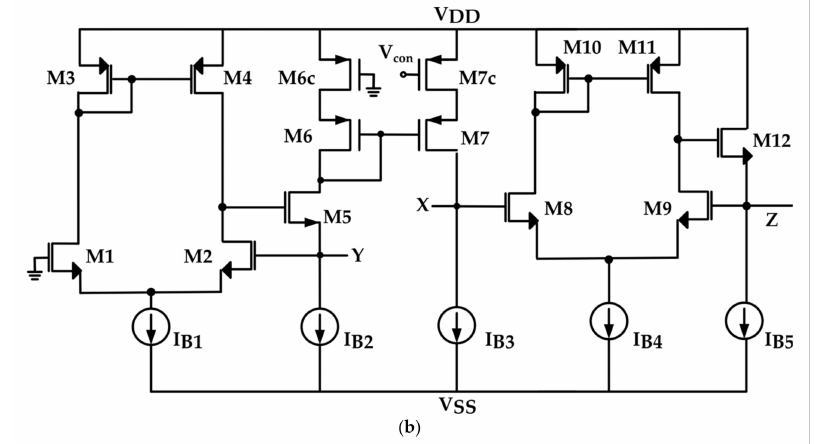
Figure 5. CMOS implementation of the used ( a ) CVCII 1+ and ( b ) CVCII 2+ .